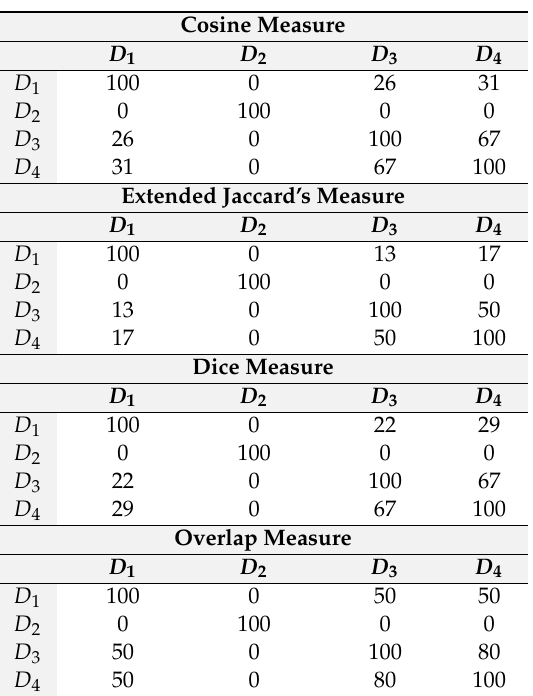
Table 4. Results of similarity